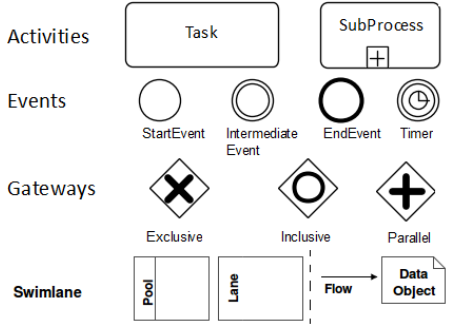
Figure 5. The basic elements of the